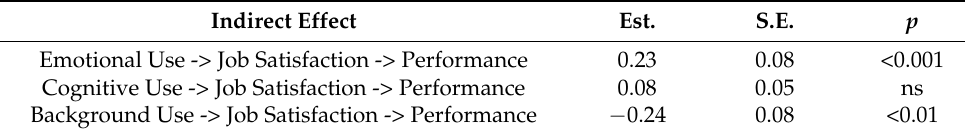
Table 4. Indirect effects of the